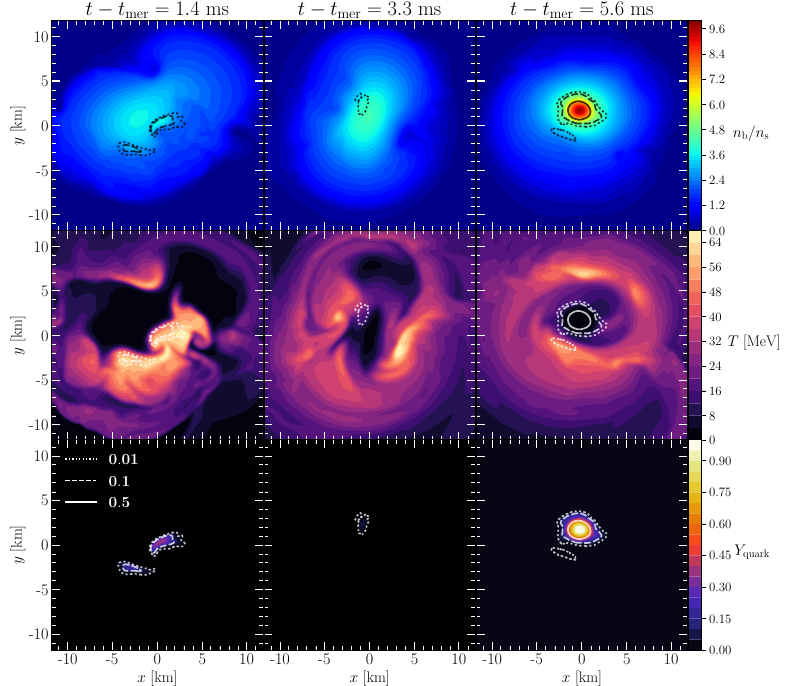
Figure 2. From top to bottom rows we show snapshots of the baryon-number density, temperature, and quark fraction in the orbital plane at three di ff erent times t − t mer = 1 . 4 , 3 . 3 , 5 . 6 ms (from left to right) that are representative for hot, warm and cold quark stages of a q = 0 . 7 simulation with soft V-QCD EOS. In addition, we mark contours for the quark fraction Y quark = 0 . 01 , 0 . 1 , 0 . 5 by dotted, dashed and solid lines, respectively. See [26] for